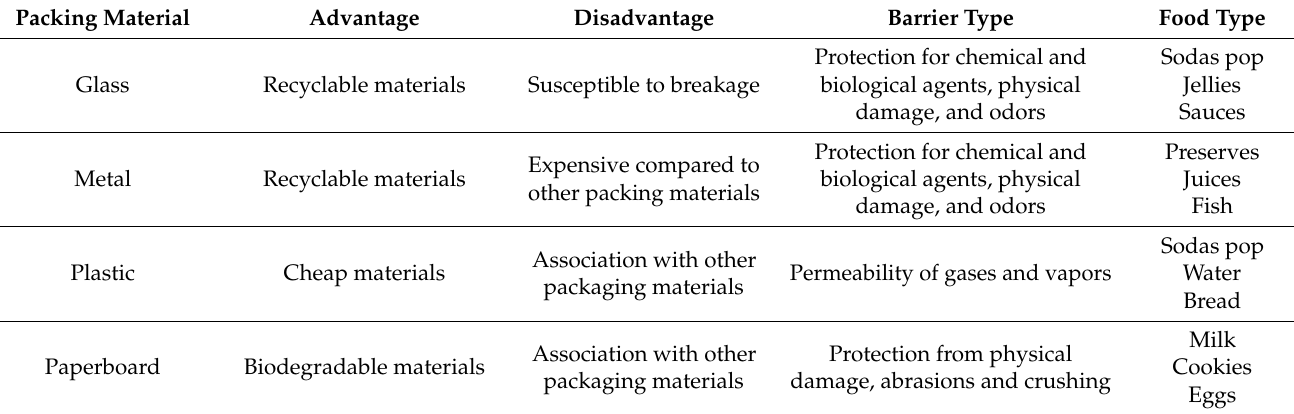
Table 1. Some advantages, disadvantages of the conventional packing materials